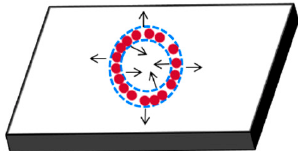
Figure 7. Schematic illustration of a particle-imprinted substrate sample. The inner radial liquid–air interface initiates inwards flow (in addition to outwards flow) to suppress the ring-clustering phenomenon.